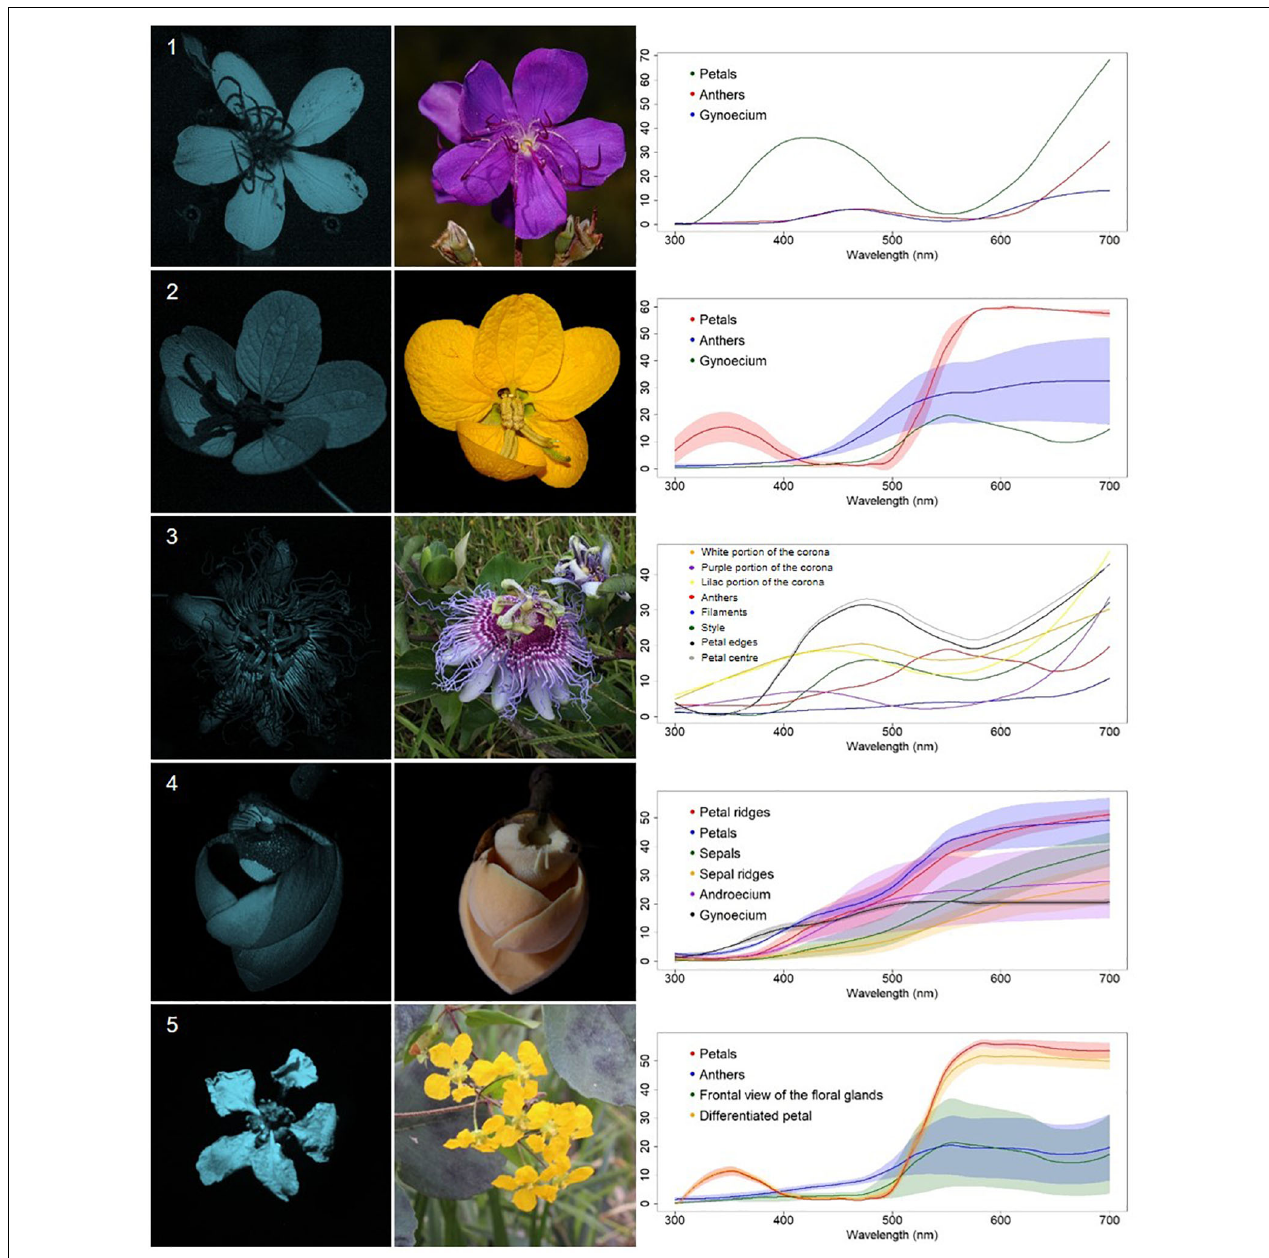
FIGURE 5 | Contrasting reproductive structures UV-patterned flowers (CR) from a Neotropical savanna community. Each row comprises information of one species. First column: UV-photography. Second column: flower as seen by the human eye (conventional photography). Third column: reflectance curves of different portions of the flowers. Row 1. Pleroma stenocarpa (DC.) Cogn. (Melastomataceae). Row 2. Senna rugosa (G.Don) H.S.Irwin and Barneby(Leguminosae). Row 3. Passiflora cincinnata Mast. (Passifloraceae). Row 4. Annona coriacea Mart. (Annonaceae). Row 5. Janusia guaranitica (A.St.-Hil.) A.Juss.